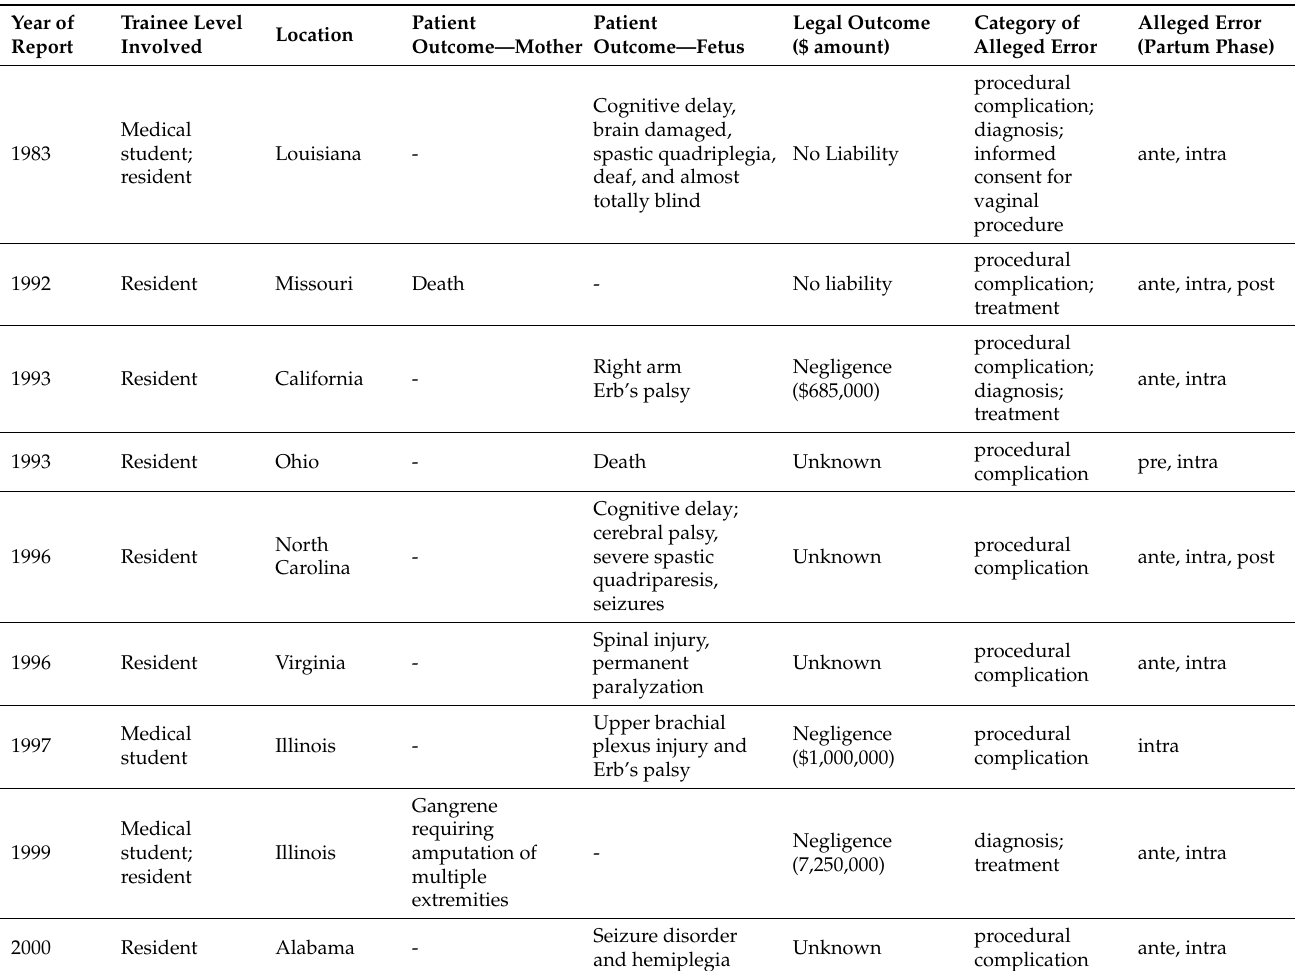
Table 3. Summary table of individual legal cases involving trainees in